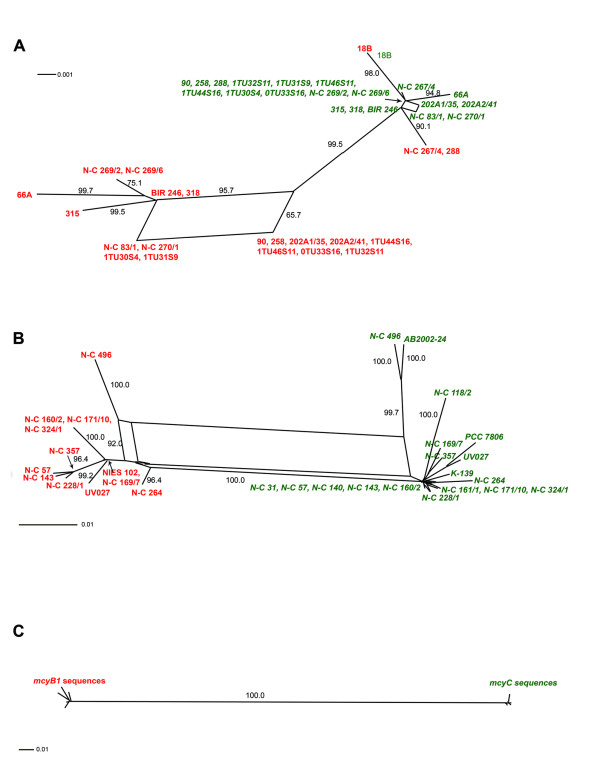
Splits decomposition analysis of adenylation domain encoding sequences of mcyB1 and mcyC. Shown are Anabaena (A), Microcystis (B) and Planktothrix (C). mcyB1 and mcyC sequences are indicated by red and green, respectively. Bootstrap values above 50% are shown. Within mcyC sequences of Microcystis, all branches have bootstrap values ranging from 88–100%.